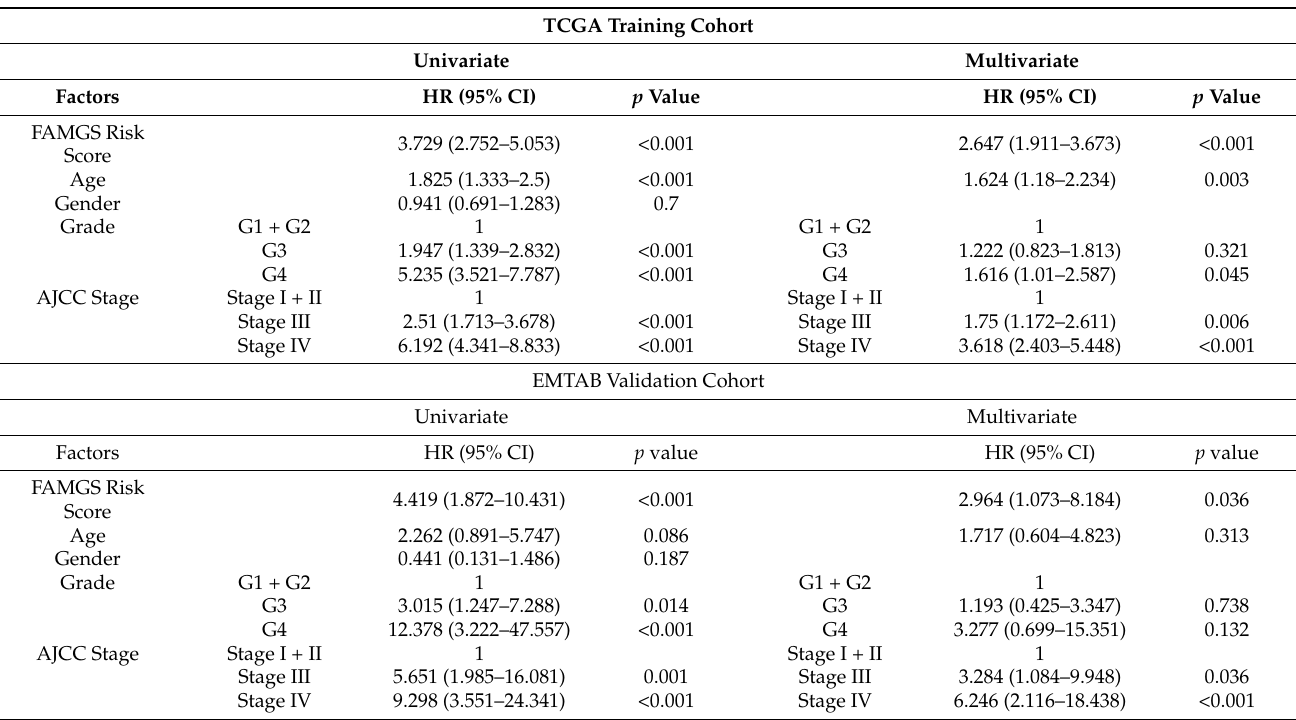
Table 2. Univariate and multivariate Cox regression analyses for predicting OS in the TCGA training cohort and EMTAB validation